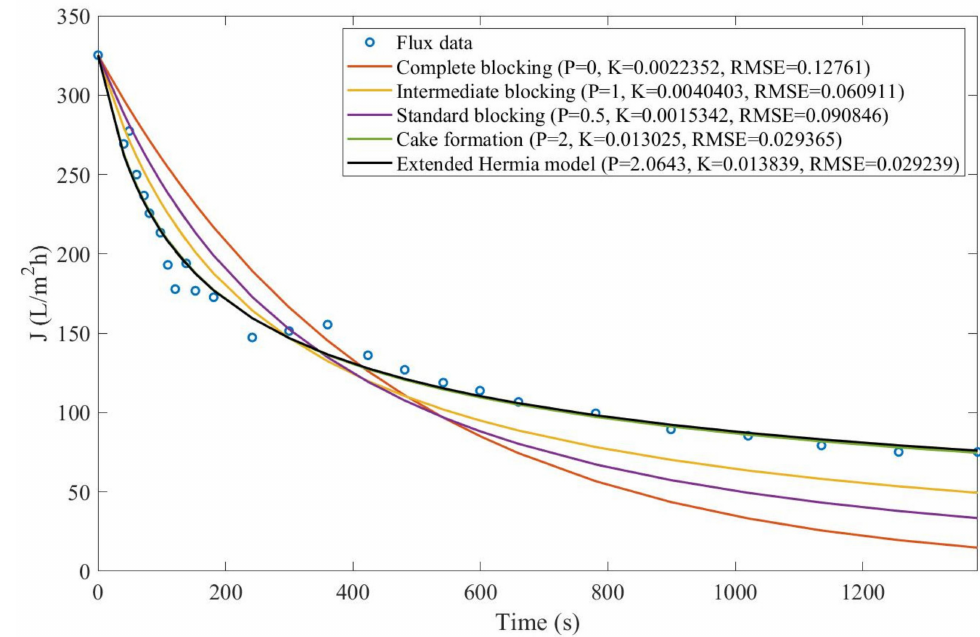
Figure A37. Model fitting for dead-end ultrafiltration of nanoparticles (251 mgNPs/L) from polishing wastewater at 0.4 bar considering the four original pore-blocking mechanisms and the extended Hermia model